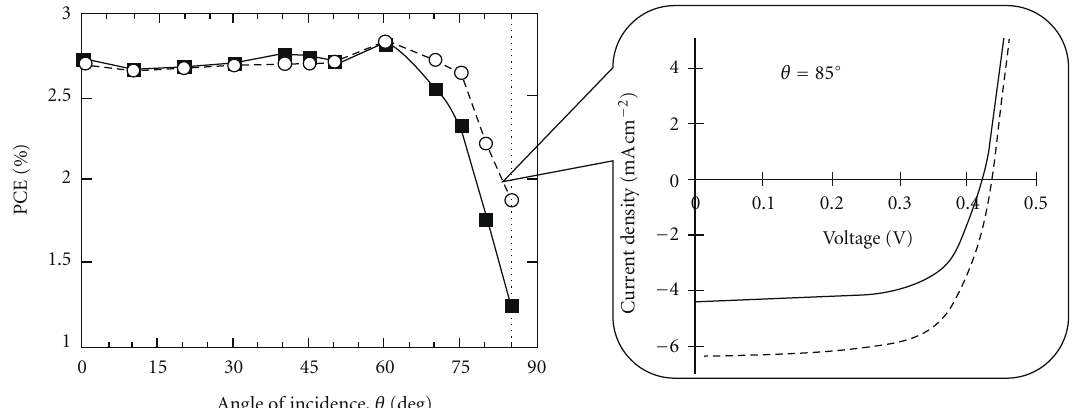
Figure 7: Comparisons of incident angle dependencies of PCE between BHJ organic solar cells of P3HT: PCBM with ( (cid:2) ) and without ( (cid:2) ) TiO 2 NWs, and their typical J - V curves (at θ = 85 ◦ ).